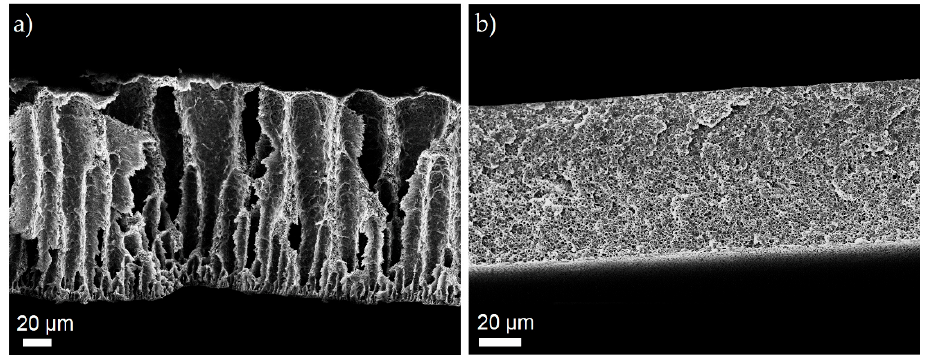
Figure 1. Representative SEM images of the cross-sectional morphologies of the membranes ( a ) M1’-35NT, and ( b ) M1’-75NT.